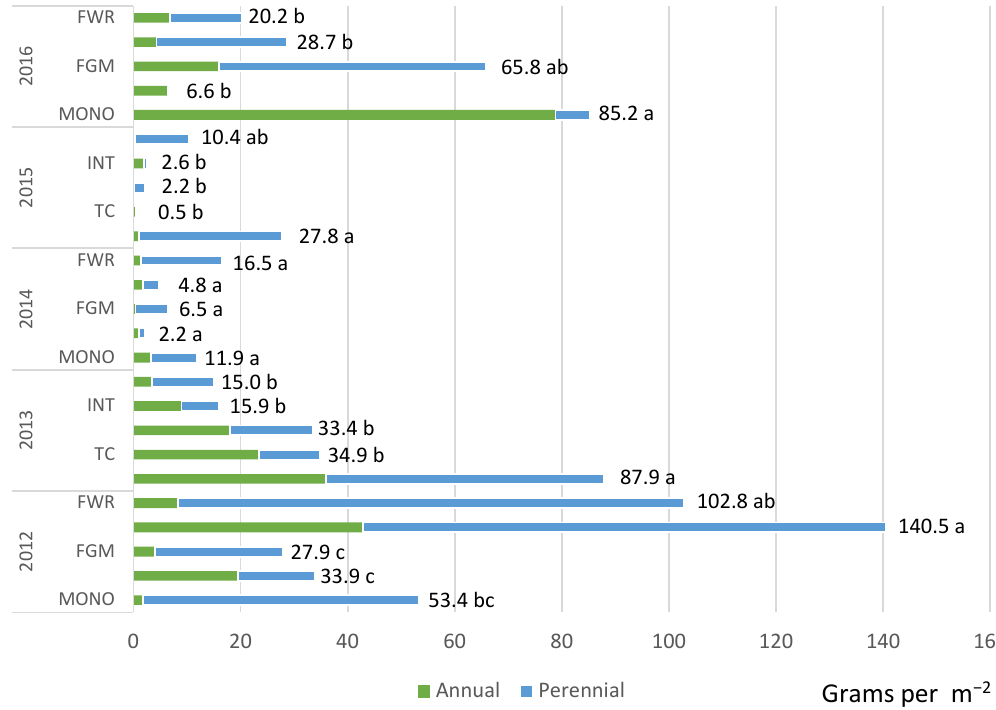
Figure 3. The mass of weeds in winter rye crop in different rotations before the harvest in 2012–2016. Note: different letters indicate significant differences between the treatments ( p ≤ 0.05); FWR—field rotation with row crops; INT—intensive rotation; FGM—rotation for green manure; TC—three-course rotation; MONO—rye monoculture.